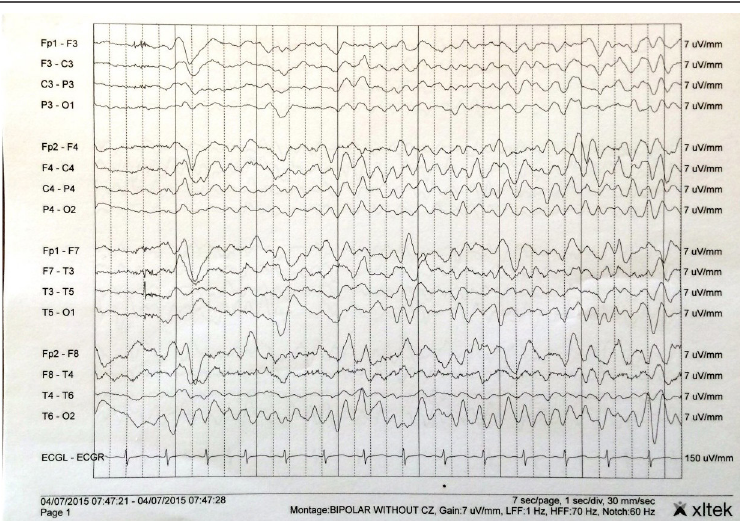
Figure 1. Repeat Electroencephalogram of the Patient